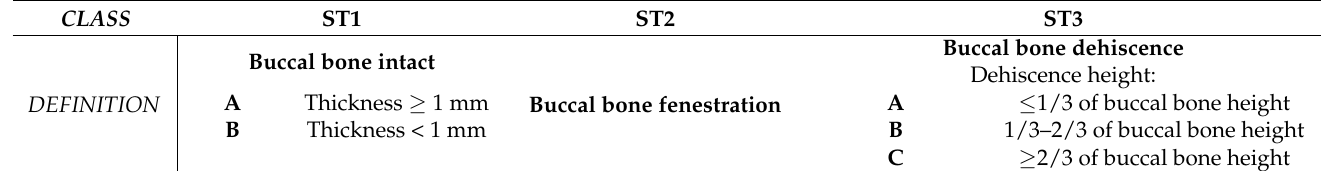
Table 1. Socket type (ST) classification. Anatomy of the post-extractive socket has been classified in three categories based on buccal bone characteristics including height, thickness and presence of dehiscence or fenestration. ST classification represents an evaluation of the self-contentive anatomy of the socket that ranges from highest regenerative potential for ST1 to lowest for